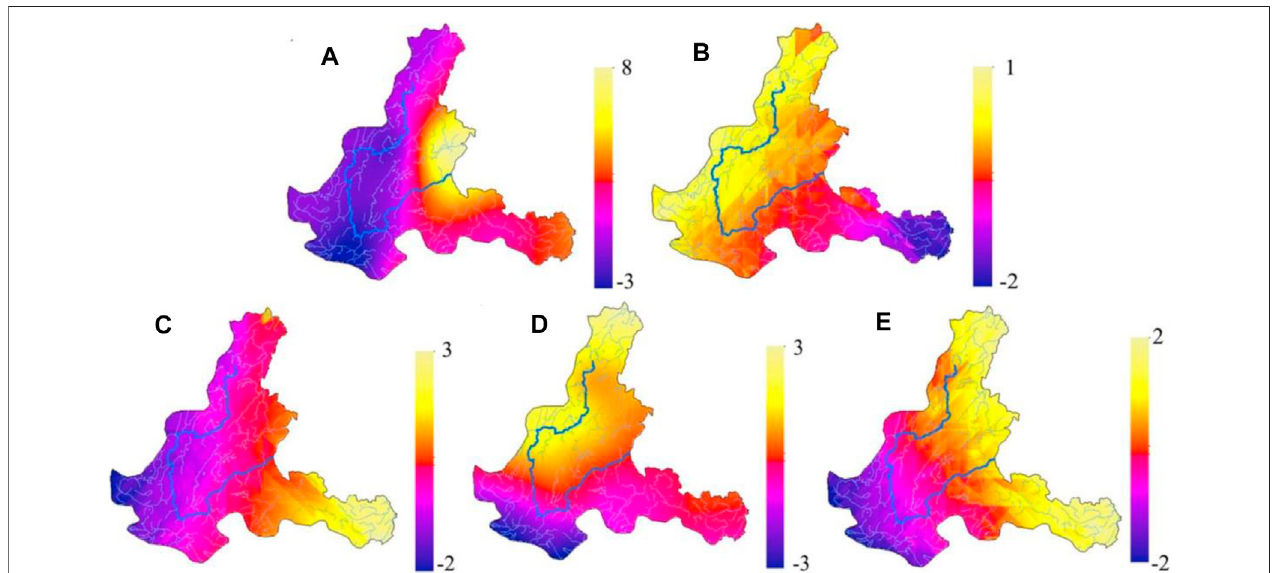
FIGURE 4 | Spatial distribution of the fi rst fi ve principal components loadings (A : PC1 B : PC2 C : PC3 D : PC4 E : PC5 ) .